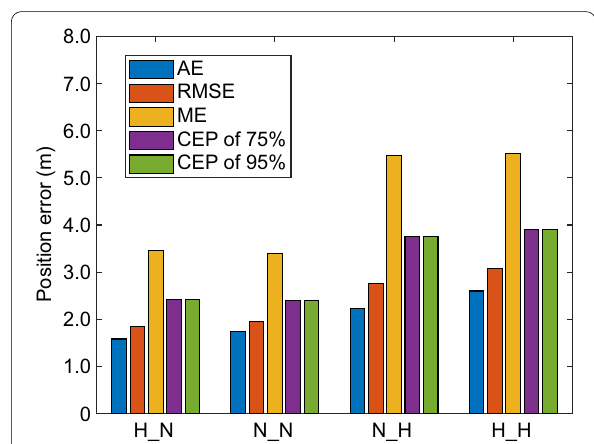
Fig. 23 Position errors using different smartphones. H-N